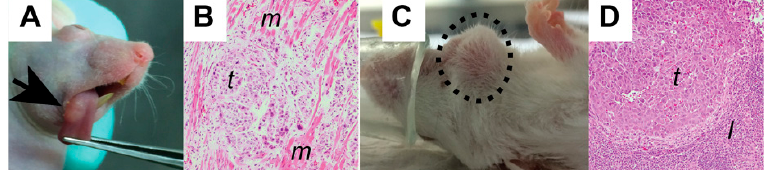
Figure 2. Orthotopic head and neck cancer models. ( A ) Orthotopic growth of a PDX within the tongue (arrow) can be seen with careful inspection. ( B ) On histologic evaluation the tumor (t) can be seen infiltrating into tongue muscle (m). ( C ) Lymph node metastases (dashed circle) can be seen following orthotopic tumor injection, but are less commonly seen with flank models. ( D ) Histologic evaluation demonstrates the tumor (t) within a lymph node (l).